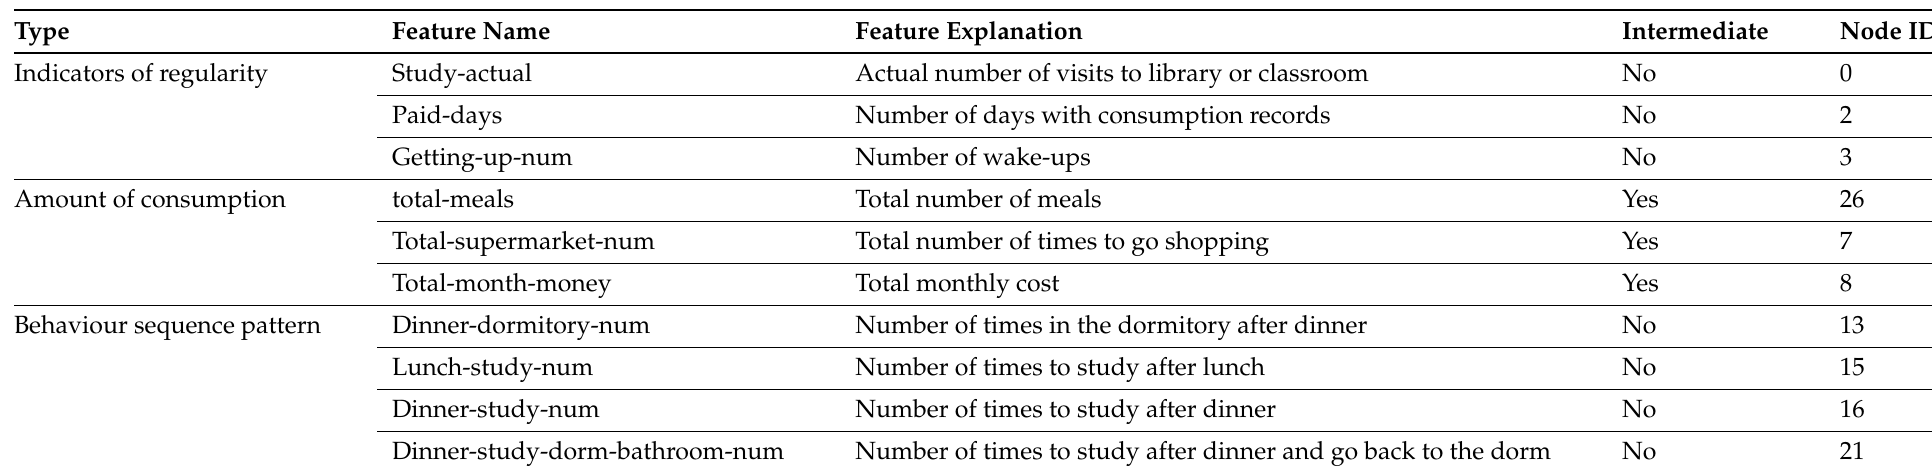
Table 3. Extracted features based on students’ data and